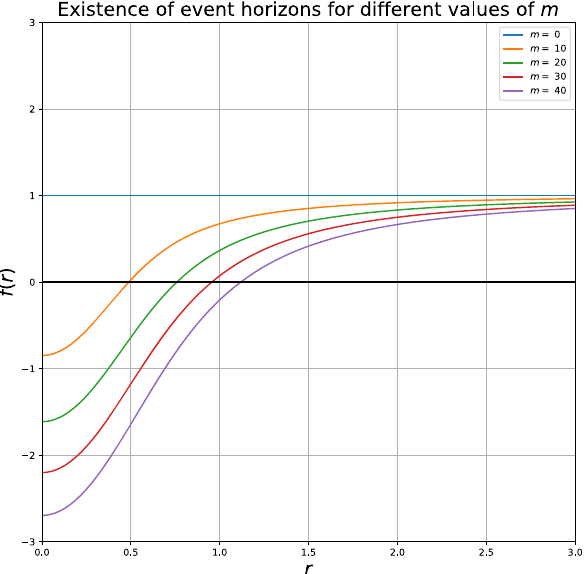
right panel lead to asymptotically AdS 5 × R black strings. Note that the metric function f ( r ) is regular at the origin, as it occurs for EGB in five dimensions in